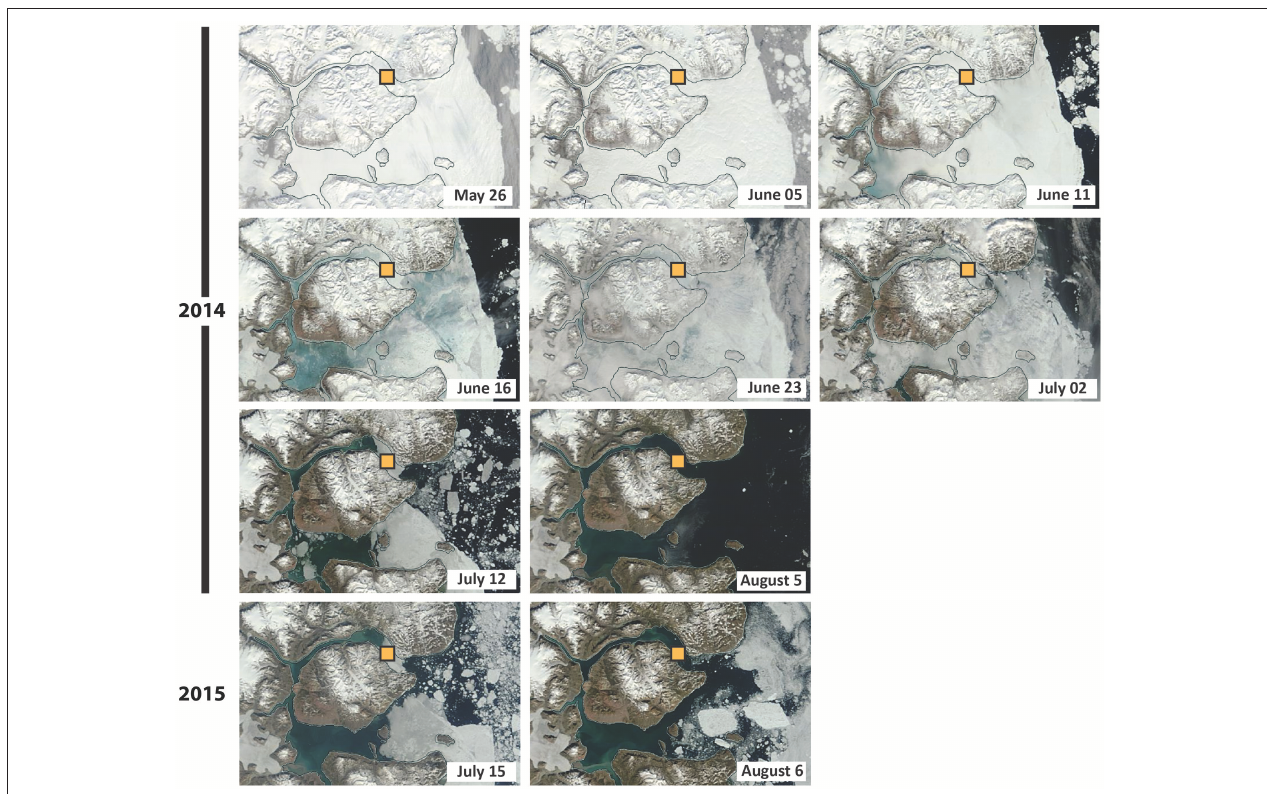
FIGURE 2 | Seasonal sea-ice conditions (based on MODIS imagery) for the years 2014 and 2015. The sampling area is indicated by the yellow square.